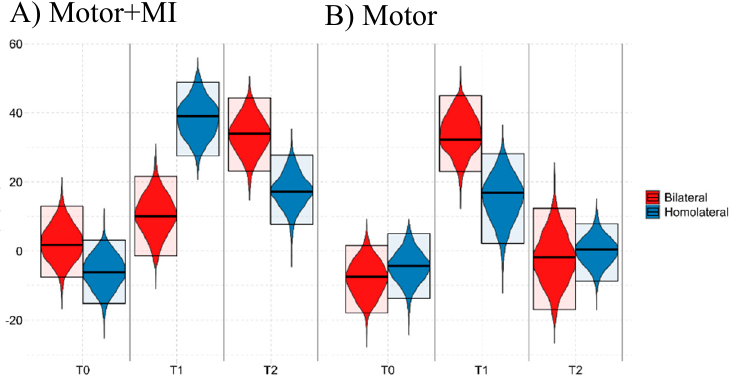
Figure 5. Graphical representation of the marginal posterior distributions of the Space:Condition:Time interaction in the REAL condition. The violin plots represent the marginal posterior distribution of the Bayesian model, the upper and lower boundaries of the box show the limits of the 95% HDI, while the central line represents the distribution mode. On the y − axis, the marginal posterior distribution (P( θ |D)), in milliseconds, represents the performance of the participants, and the x − axis shows the Time points: T0 (pre training), T1 (post training) and T2 (follow-up). ( A ) = Motor+MI, ( B ) = Motor. H1 = Pr(x > 0) > 83.5%, meaning that Homolateral > Bilateral, index of PPS representation. H2 = Pr(x > 0) < 16.5%, meaning that Bilateral > Homolateral, and with no PPS representation.